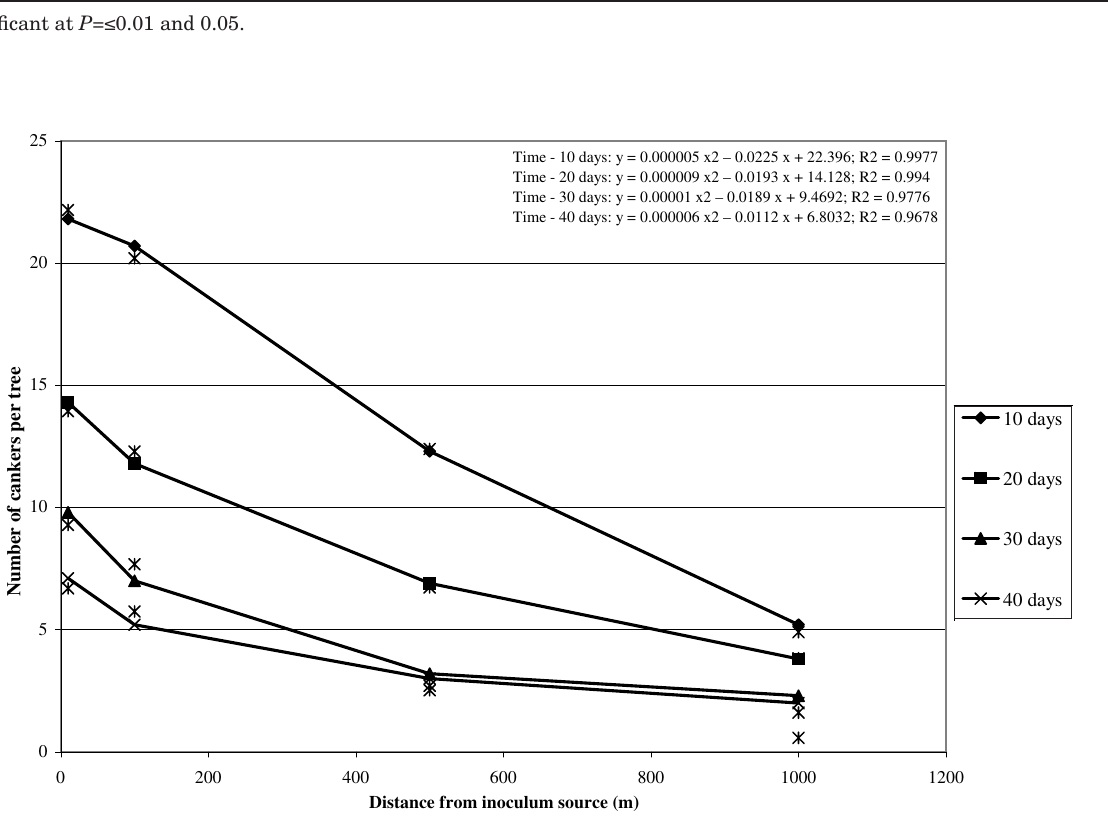
Fig. 3. Disease gradient of Apiognomonia quercina on Quercus cerris and Quercus pubescens . Average number of cankers per tree was determined on the twigs of 15 trees (2 twigs per compass point = 8 twigs per tree) at each of four sampling points (10, 100, 500 and 1000 m from the inoculum